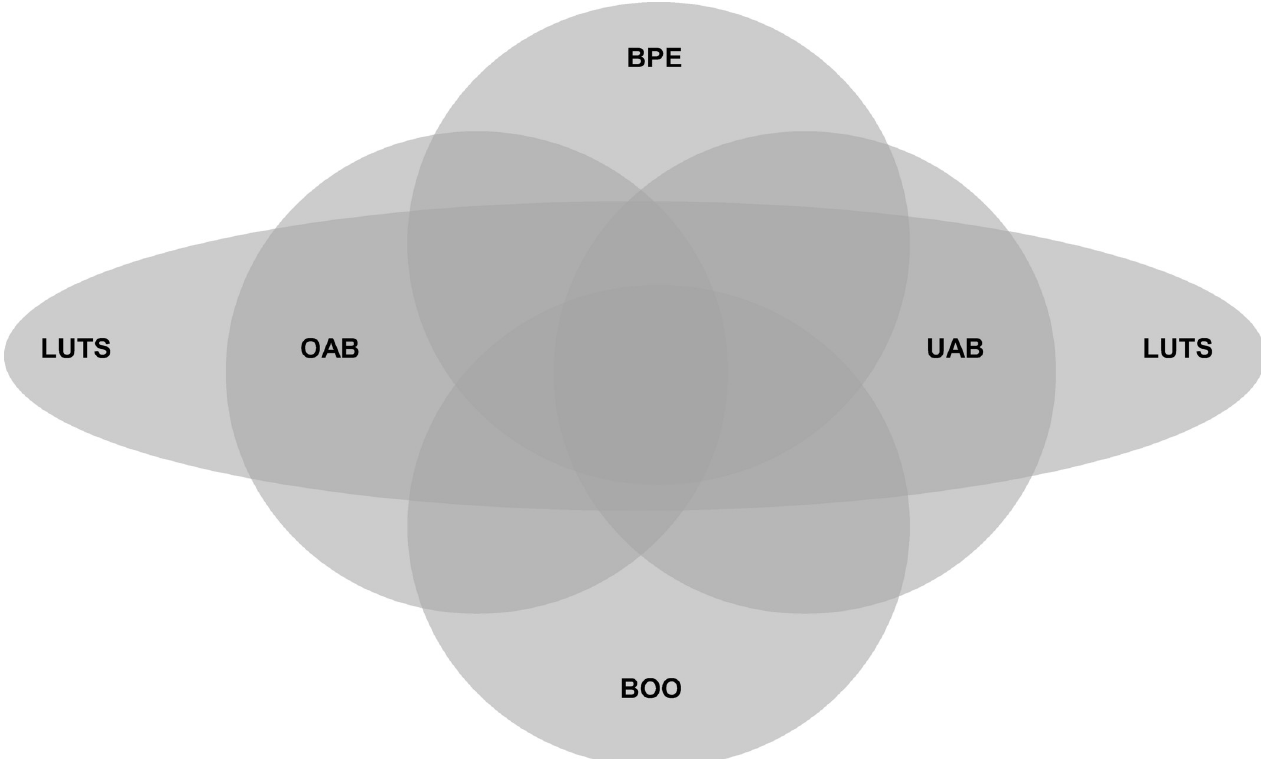
Fig 5. Venn diagram illustrating the complexity of BPH/LUTS. Symptoms variably overlap with benign prostate enlargement (BPE), bladder outlet obstruction (BOO), overactive bladder (OAB) and underactive bladder (UAB).